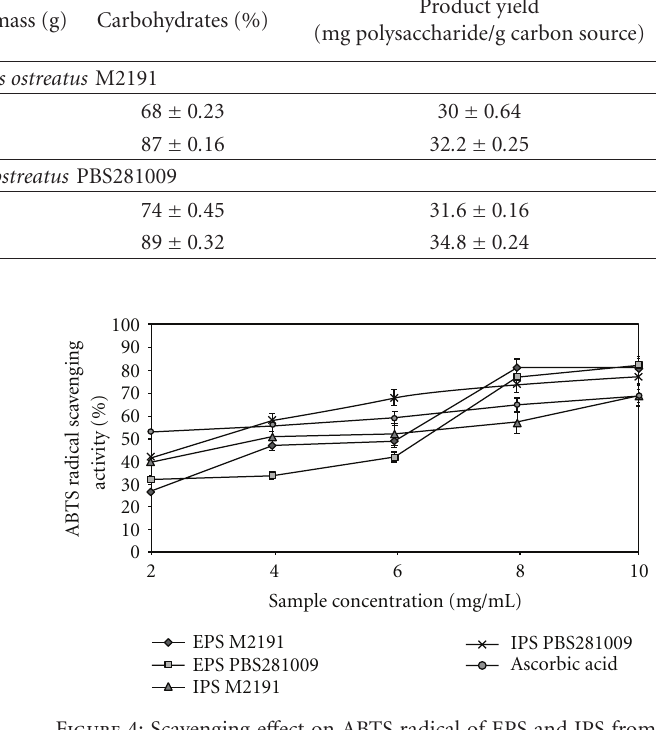
Figure 3: Scavenging e ff ect on 1,1-diphenyl-2-picrylhydrazyl rad- ical of EPS and IPS from submerged culture of Pleurotus ostreatus M2191 and PBS281009.